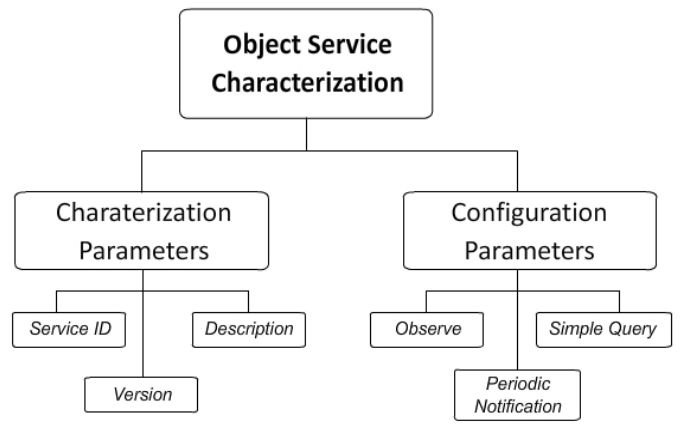
Figure 2. Service